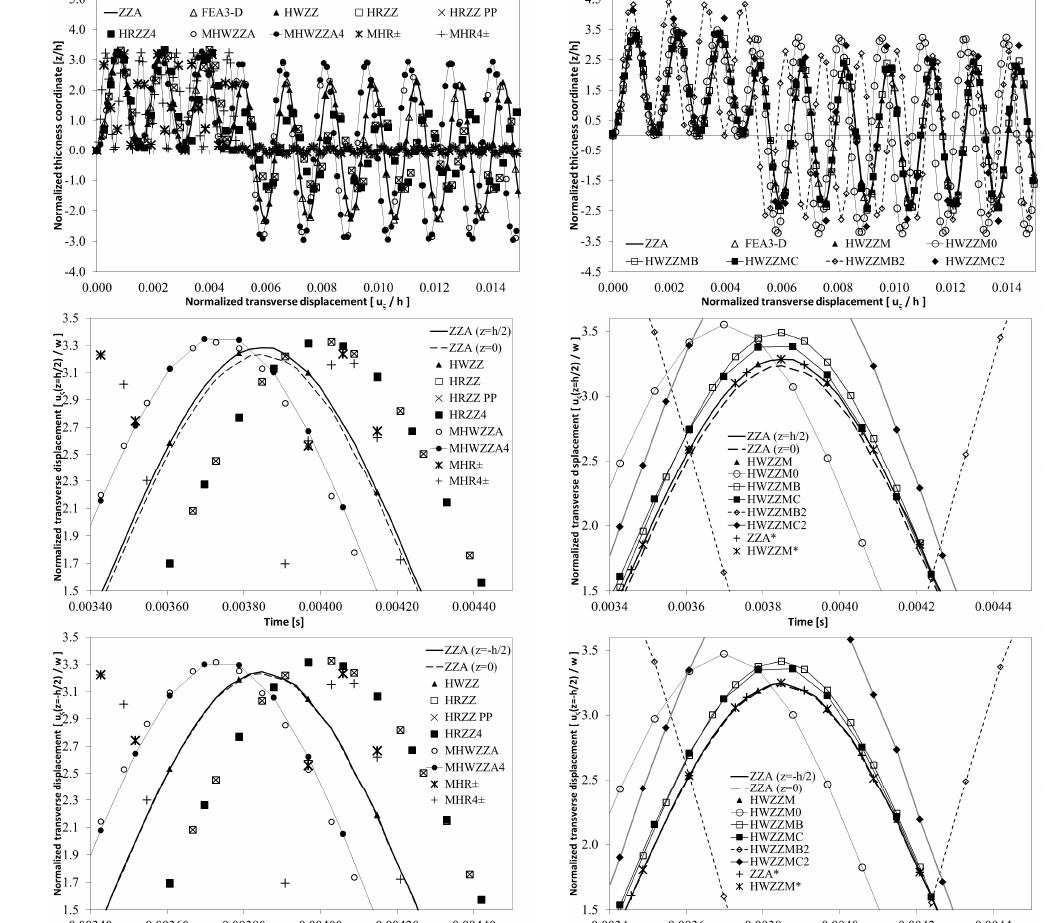
Figure 13. Case i3: Normalized transverse displacement of a simply supported sandwich plate under a step blast pulse loading ( L x/ h = 10).